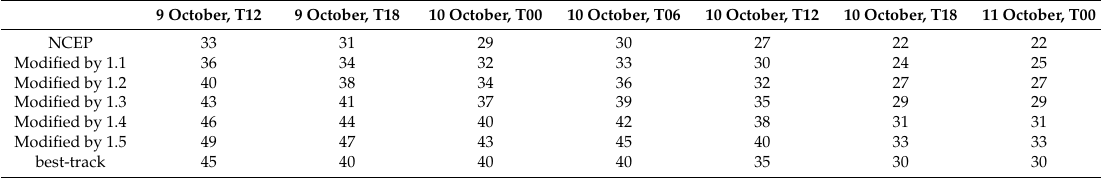
Table 3. Comparison of the maximum wind speed (m/s) between the NCEP, modified and best-track wind fields.